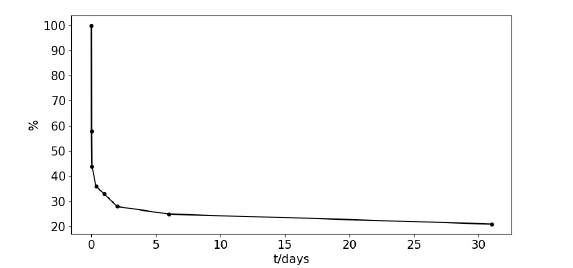
Figure 8. The Ebbinghaus